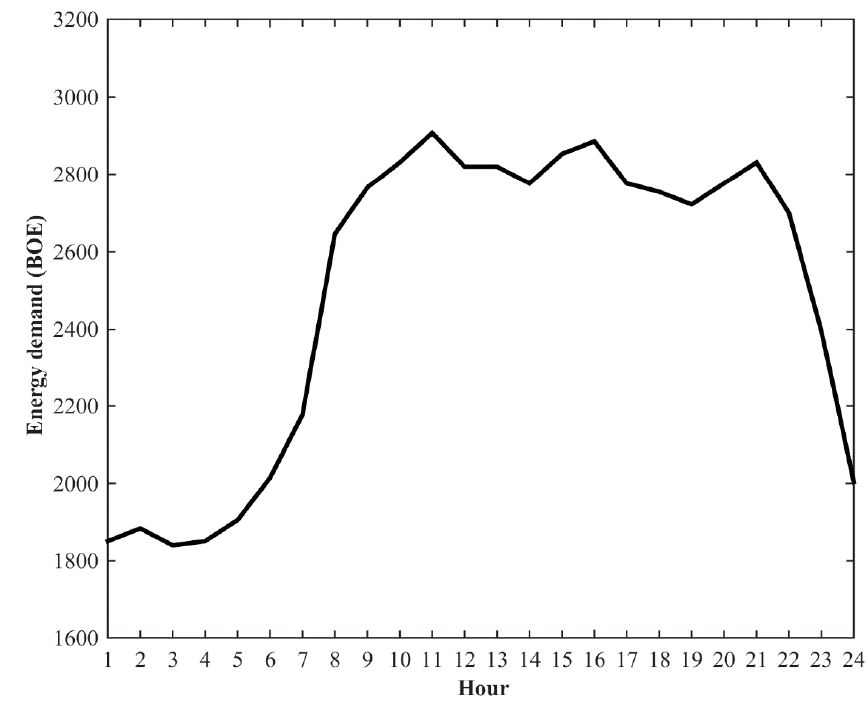
Figure 1. Energy demand profile.